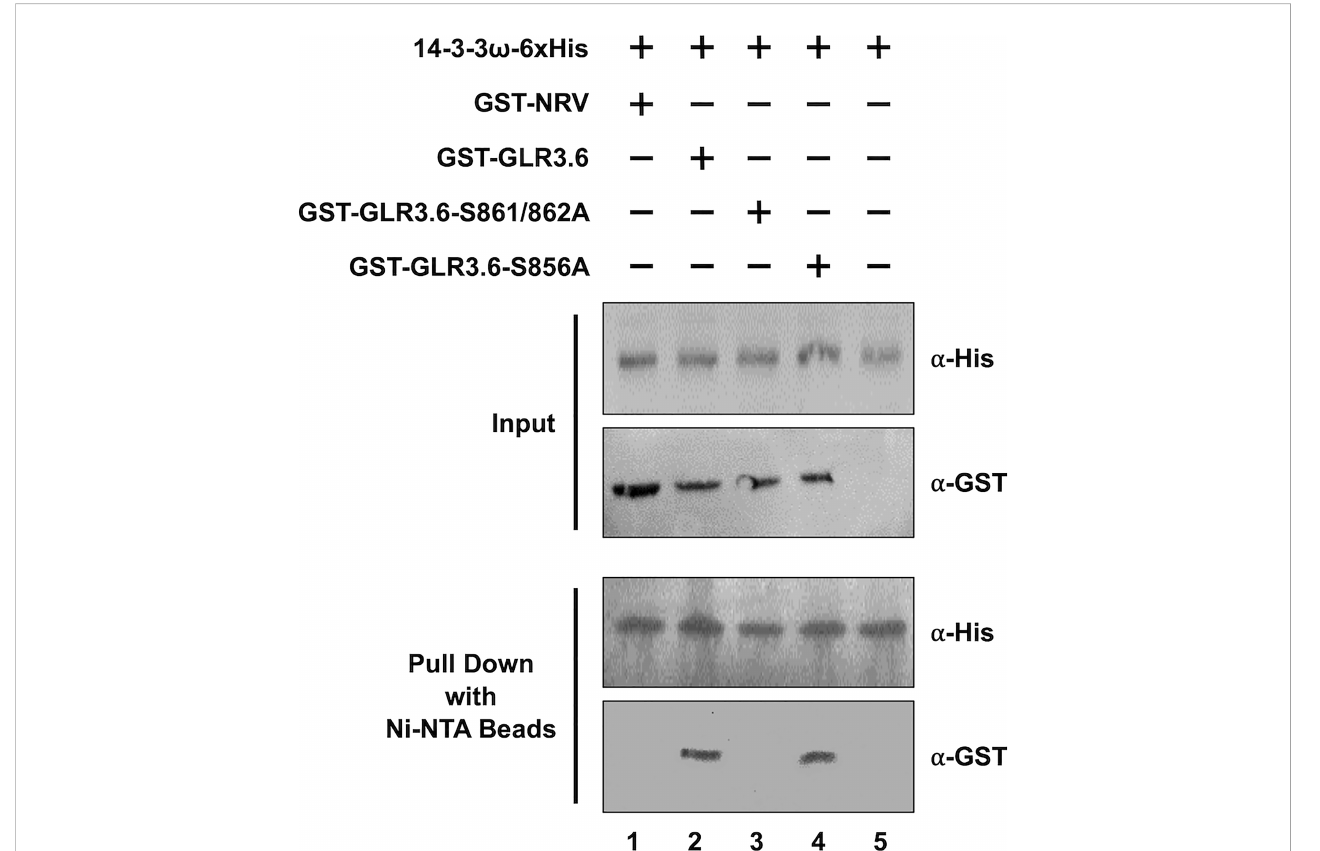
FIGURE 6 GLR3.6 interaction with 14-3-3 w was veri fi ed in vitro using pull-down assay. Recombinant 6xHis-14-3-3 w mixed with GST-NRV and GST-fused peptide fragments of GST-GLR3.6, GST-GLR3.6-S861/862A, or GST-GLR3.6-S856A were analyzed by western blotting using the antibodies a -His and a -GST